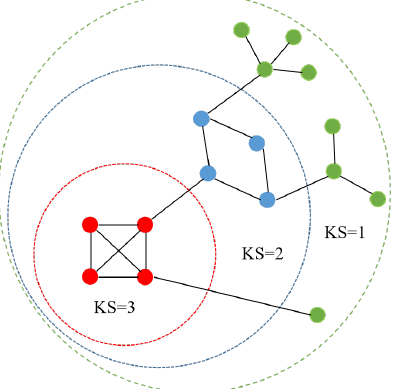
Figure 1. Diagram of k-shell decomposition